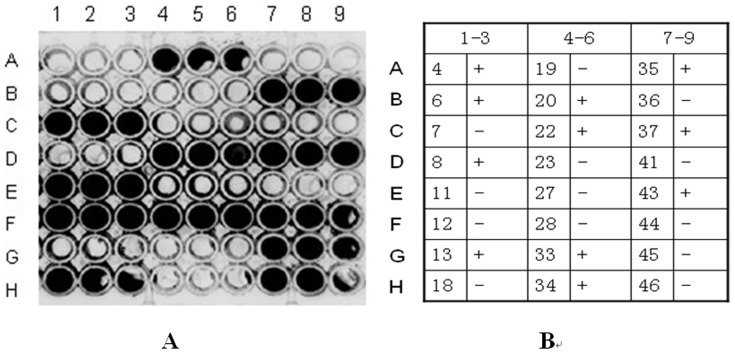
Chemiluminescent detection of competitive inhibition of LBP binding to CD14 by phage clones.A. Non-luminescent particles indicated clones with competitive binding capacity. B. Number of single clones corresponding to the chemiluminescence plate labels and their competitive inhibition status. “+” indicates competition with LBP, “−” indicates no competition.